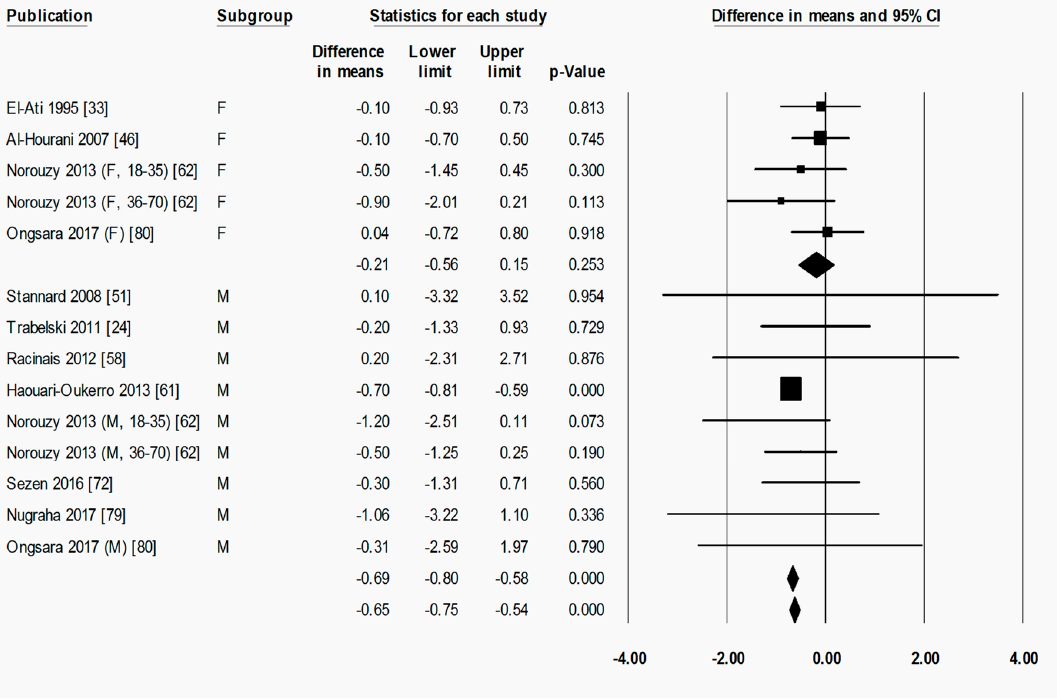
Figure 8. Fat-free mass was significantly decreased by Ramadan fasting in the male but not in the female subgroup. Change in fat-free mass (kg) as subdivided by sex (female and male), between pre-Ramadan (pre-R) and the end of Ramadan (post-R). There was no significant difference between female and male subgroups ( p = 0.360). Heterogeneity statistics: female T = 0.360, p = 0.653, I 2 = 0.0%; male T = 0.000, p = 0.948, I 2 = 0.0%. F = female; M = male; 18–35, 36–70 = age range.